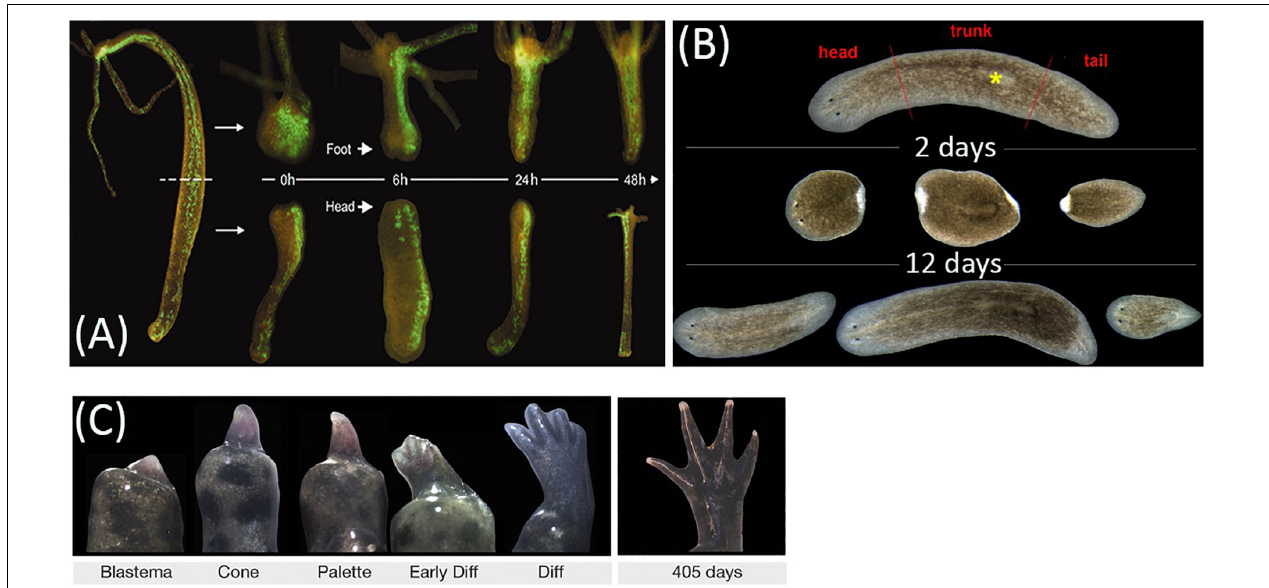
FIGURE 1 | Animal regeneration models. (A) Regeneration of head and foot in transgenic Hydra vulgaris by morphallaxis. (B) Regeneration timing in planarian Schmidtea mediterranea . (C) Epimorphic limb regeneration in axolotl Ambystoma mexicanum . Adapted from, respectively, Wittlieb et al. (2006); Adell et al. (2014), and Monaghan et al. (2014), under CC-BY. The asterisk labels the